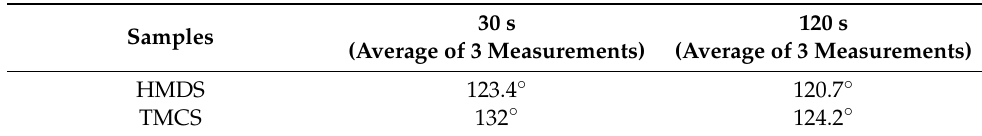
Table 8. Contact angle (CA) for the sand abrasion at an angle of 45°.